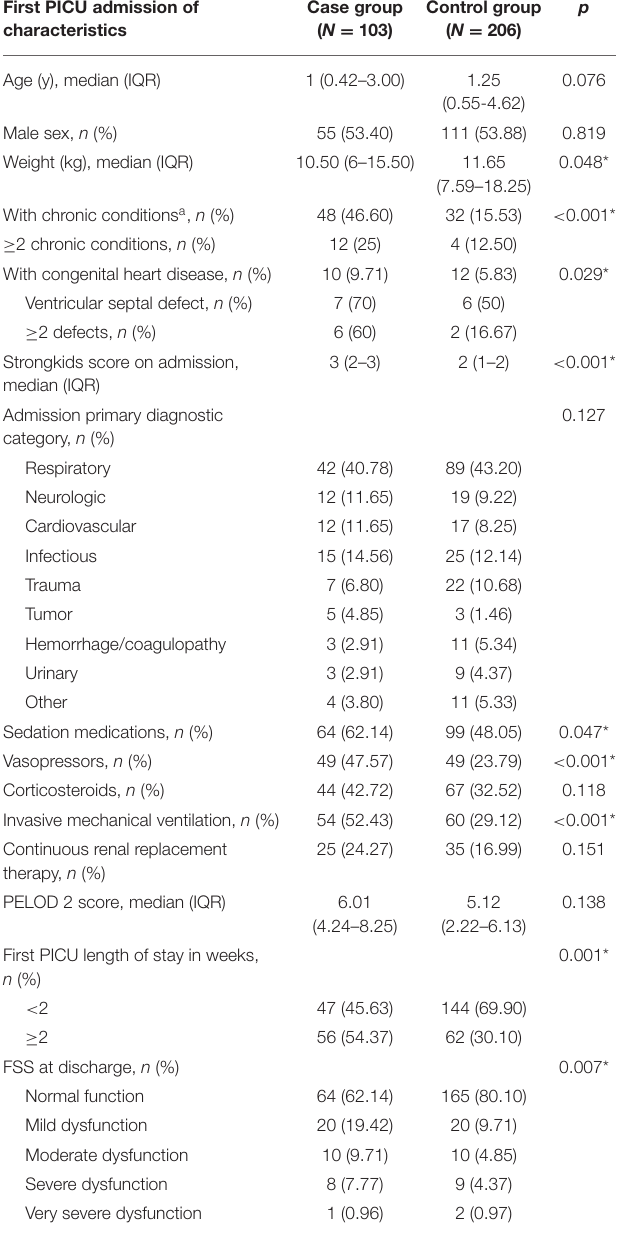
TABLE 1 | Risk factors of PICU readmission within 1 year associated with characteristics on first PICU admission.